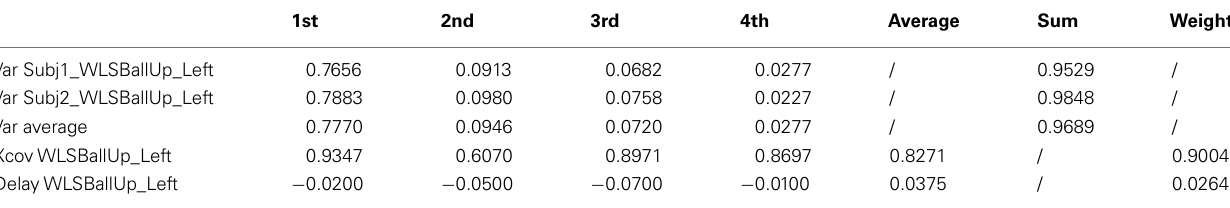
TableA7 | Reaching a target with the left hand while walking (2 subjects).